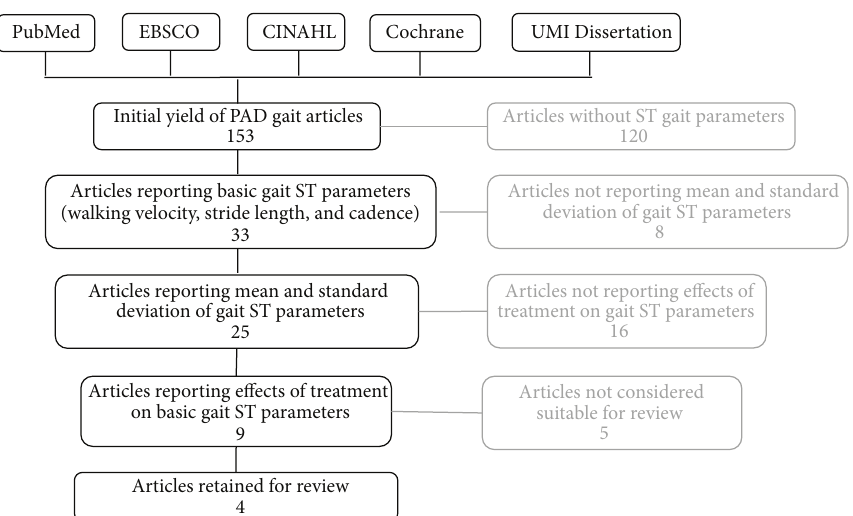
Figure 1: Diagram showing the steps of the article selection procedure which resulted in four articles being selected for detailed